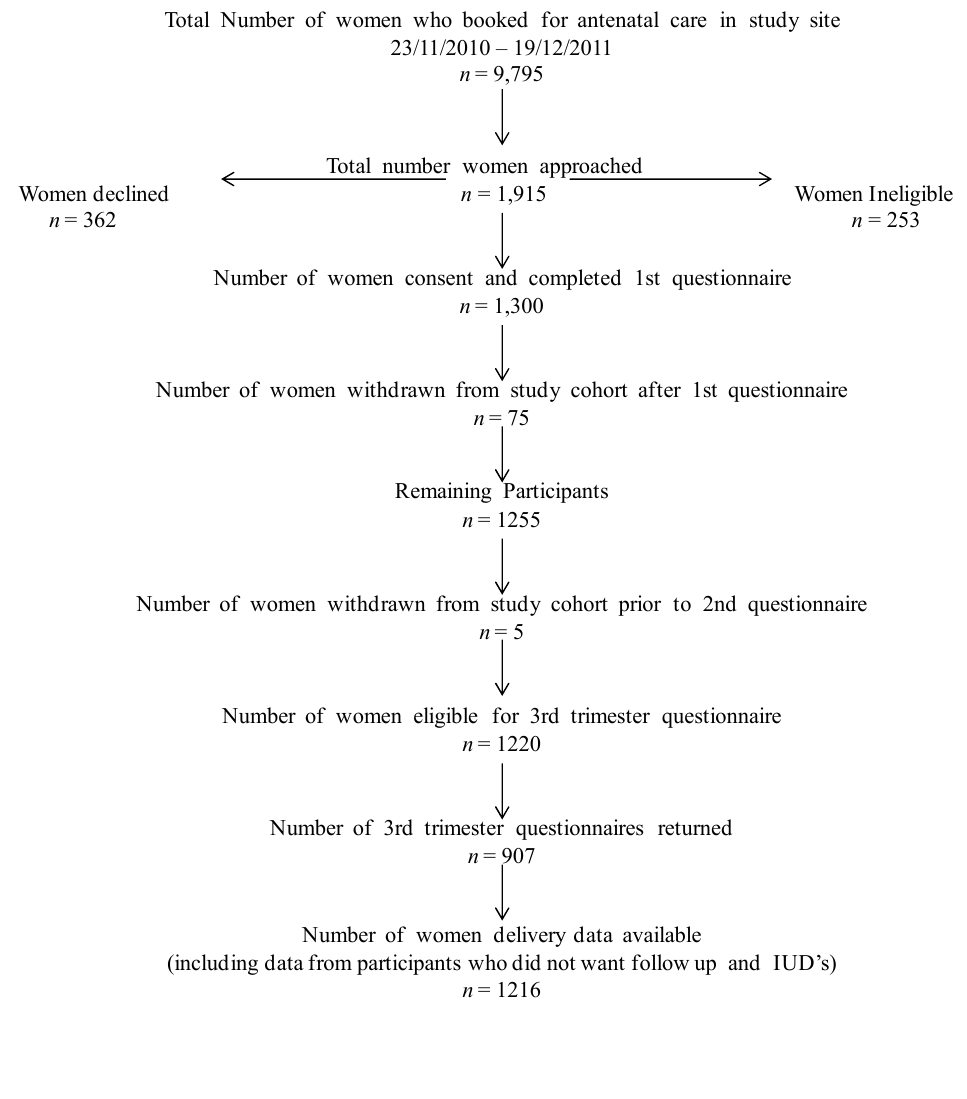
Figure 1. Cohort Flow